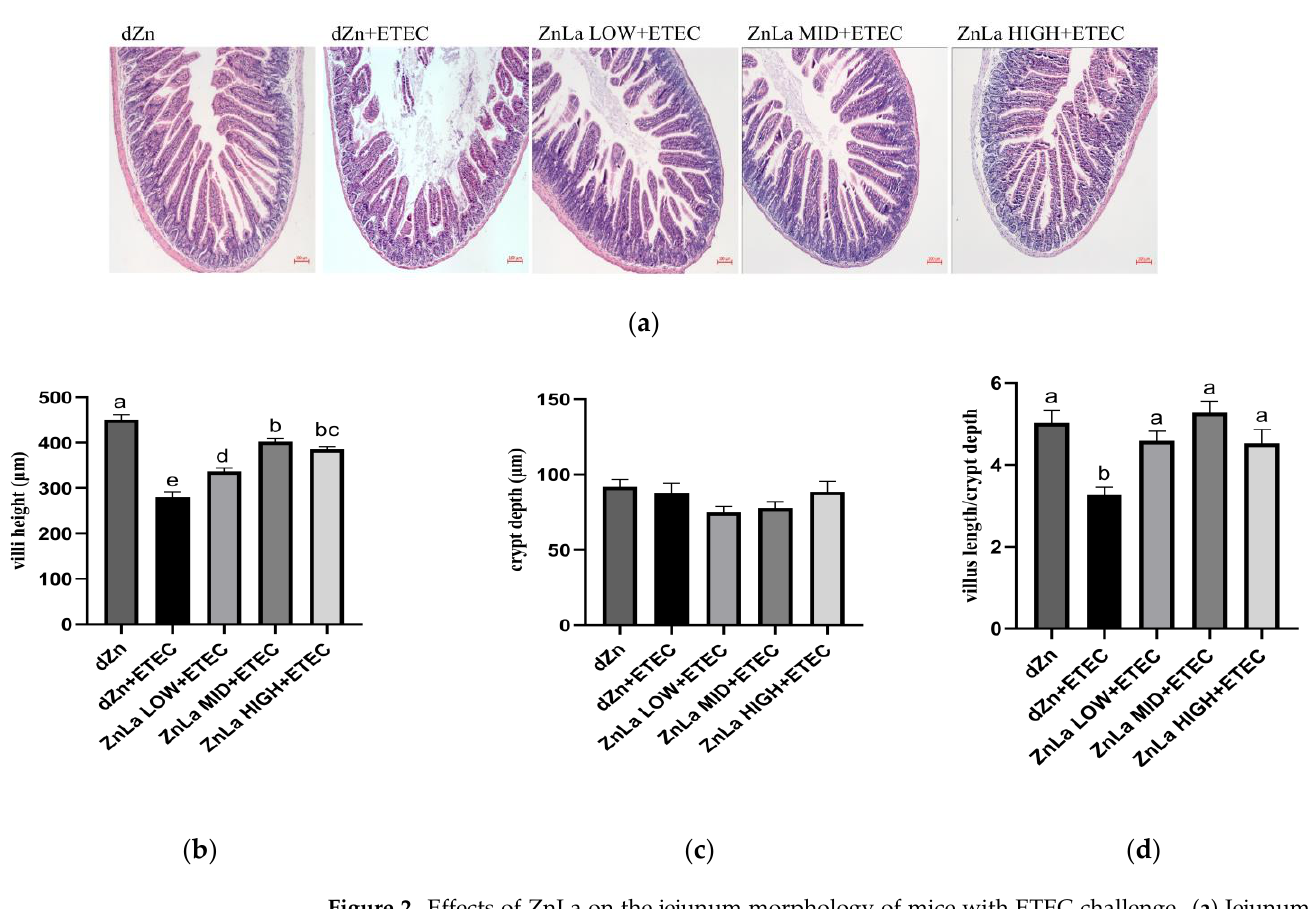
Figure 2. Effects of ZnLa on the jejunum morphology of mice with ETEC challenge. ( a ) Jejunum structure (×100). ( b – d ) The (b) villus height, (c) crypt depth, and (d) villus height/crypt depth in the jejunum. The data are expressed as mean ± s.e.m (n = 9), and different lowercase letters in each group show significant differences ( p < 0.05).